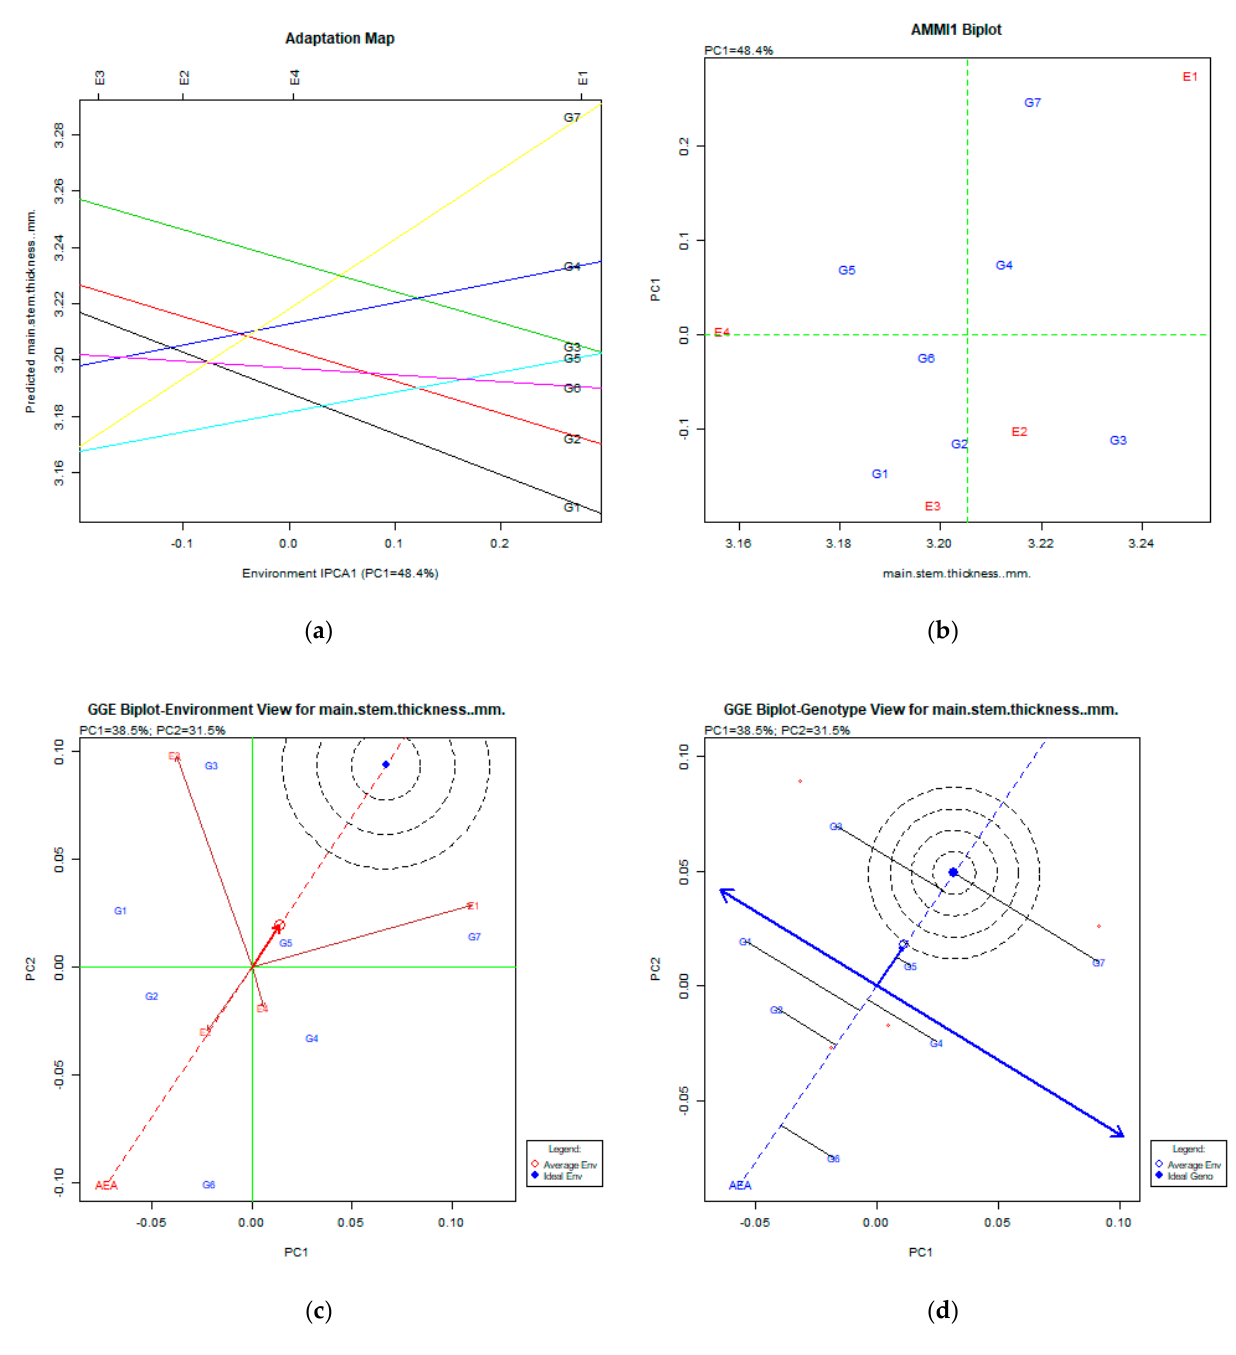
Figure 3. Stability analysis for the trait of main stem thickness (mm) based on: ( a ) adaptation map, where the environmental stability of the genotypes is visualized by the X -axis (PC1) and the performance of the trait for the genotypes is tested by the Y -axis; ( b ) AMMI1 biplot, where the environmental stability of the genotypes is visualized by the X -axis (PC1) and the performance of the trait for the genotypes is tested by the Y -axis; ( c ) GGE biplot depicting the environmental stability over time for the desirable genotypes placed near the ideal environment; ( d ) GGE biplot for genotypes depicting the genotypic stability in different environments. The desirable genotypes are those placed near the concentric region of the ideal genotype.